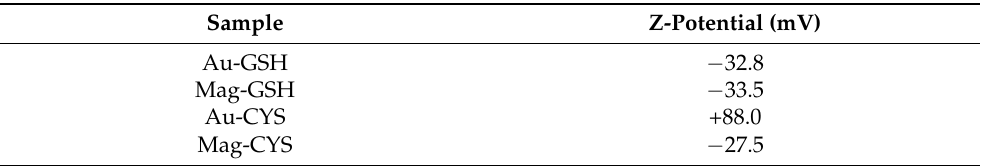
Figure 8. Z-potential versus pH for the different GSH capped NPs ( a ). Diagram of the cysteamine (CYS)-capped ( b ) and GSH-capped ( c ) magnetic-iron-oxide NPs. Diagram of the CYS-capped ( d ) and GSH-capped ( e ) gold NPs. Table 2. Z-potential values obtained for gold and magnetic-iron-oxide NPs capped with CYS and with GSH at 25 ◦ C and in PBS